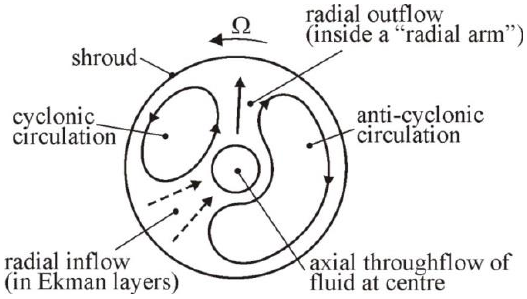
Figure 2. Schematic of flow structure in heated rotating cavity with axial throughflow of cooling air [7]. Under transient conditions in aeroengines, the throughflow can be hotter than the outer shroud, in which case stratified flow occurs and heat transfer takes place by conduction and radiation. The heat transfer for buoyancy-induced flow is much higher than for stratified flow, and the transition from one state to the other can give rise to flow